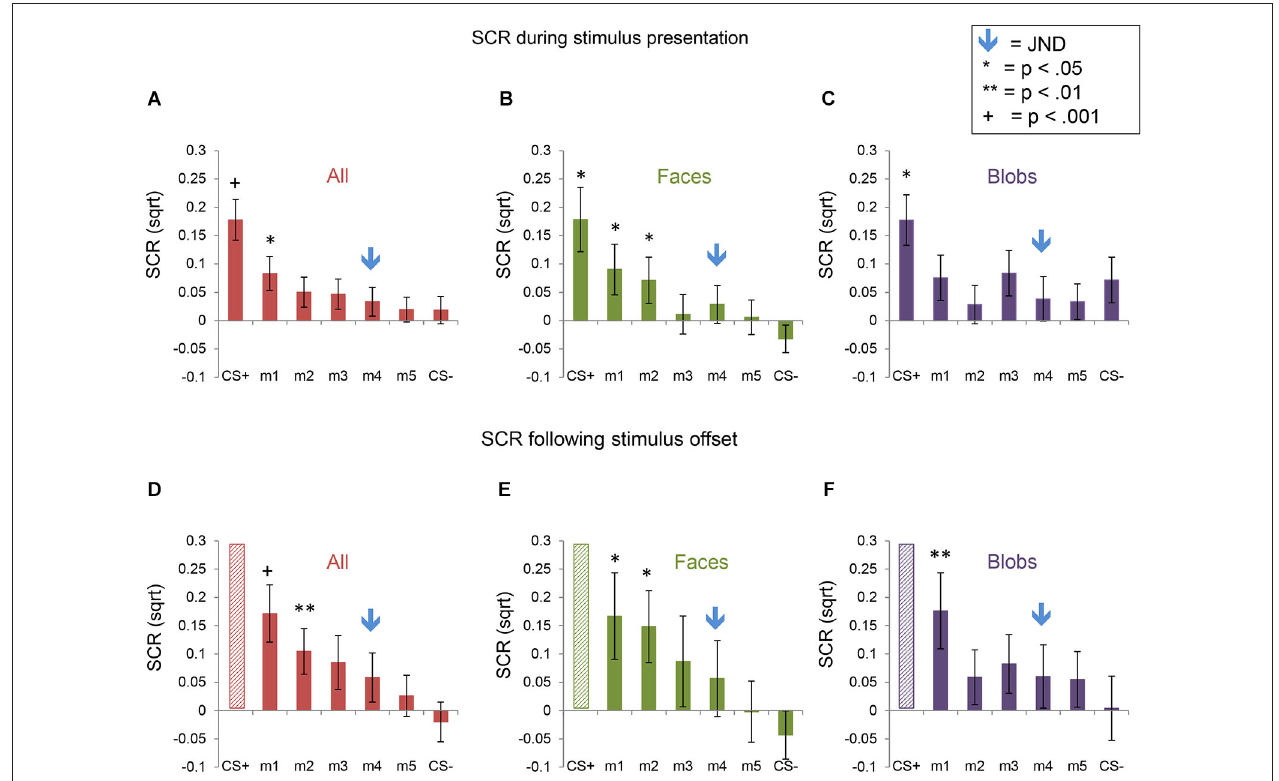
greater than the mean SCR to the CS − (* p < 0.05; ** p < 0.01; + p < 0.001). The blue arrows indicate the morph level corresponding to the JND, m4. Error bars represent one standard error from the mean. Overall, these data reveal that a similar pattern of fear generalization occurs in response to perceptually similar face and non-face control stimuli. In Experiment 1 (faces), there was significant fear generalization to m1 ( t ( 23 ) = 2.44, p = 0.02) and m2 ( t ( 23 ) = 2.30, p = 0.03) during the stimulus presentation, and to m1 ( t ( 23 ) = 2.55, p = 0.02) and m2 ( t ( 23 ) = 2.46, p = 0.02) following stimulus offset ( p s for the other morphs > 0.15). In Experiment 2, there was generalization to m1 only, following stimulus offset ( t ( 22 ) = 2.93, p = 0.008), with no significant fear generalization during the stimulus presentation (all other p s >